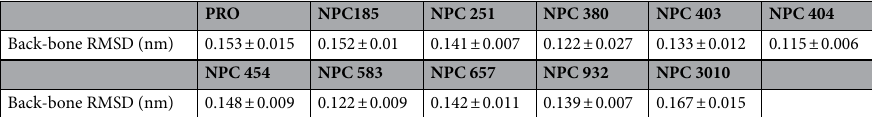
Table 4. The average of backbone RMSD of proteins during the last 10 ns of MD simulation (only the last three digit of name of compounds were mentioned).